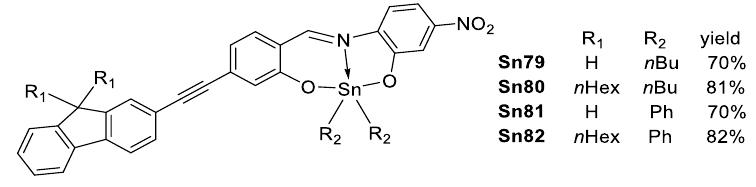
Figure 57. Diorganotin complexes derived from fluorene.